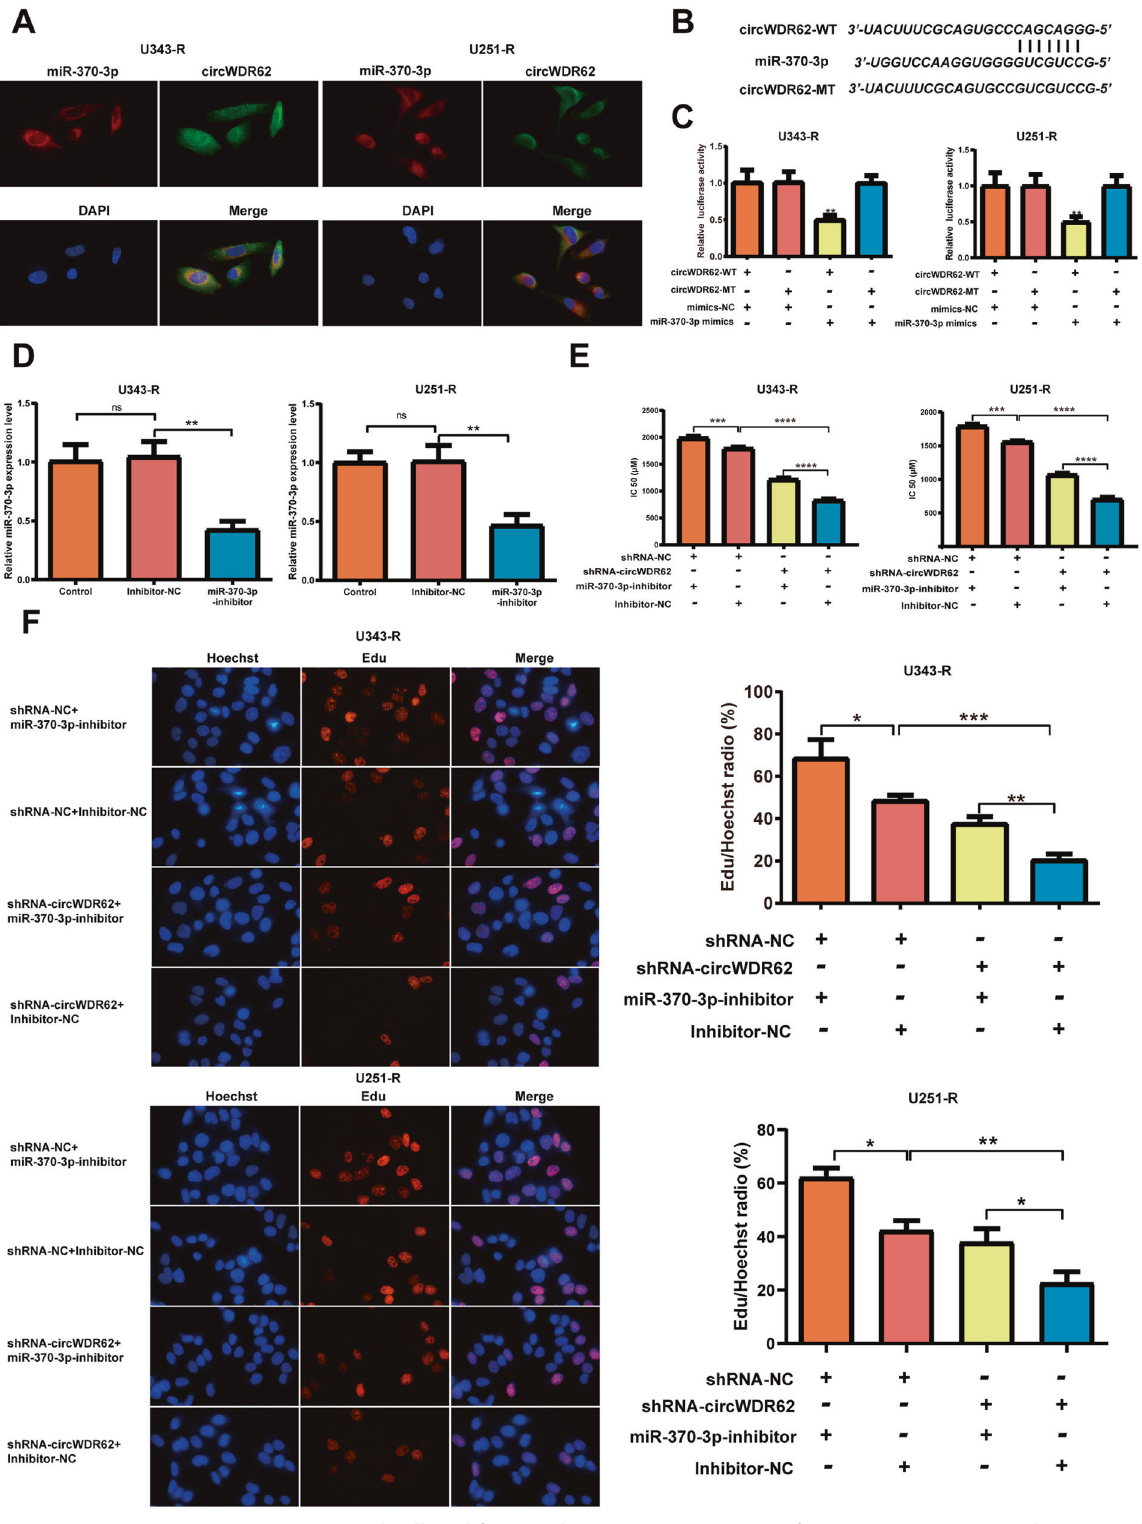
Fig. 2 circWDR62 promotes TMZ resistance and cell proliferation by acting as a sponge of miR-370-3p. U343-R and U251-R cells were transfected with shRNA-NC or shRNA-circWDR62 and miR-370-3p inhibitor or inhibitor-NC. A Colocalization of circWDR62 and miR-370-3p was analysed in U343-R and U251-R cells by FISH. B The potential binding sites of miR-370-3p within the WT or mutant circWDR62 are shown. C 293 T cells were cotransfected with the WT circWDR62 reporter plasmid or the mutant circWDR62 reporter plasmid of and miR-370-3p mimic or mimic-NC, and luciferase activity was determined. D qRT – PCR analysis demonstrated that the transfection of miR-370-3p inhibitor was successful. E The IC50 of TMZ in each group was measured by the CCK-8 assay. F The EdU assay was performed to assess cell proliferation ability in each